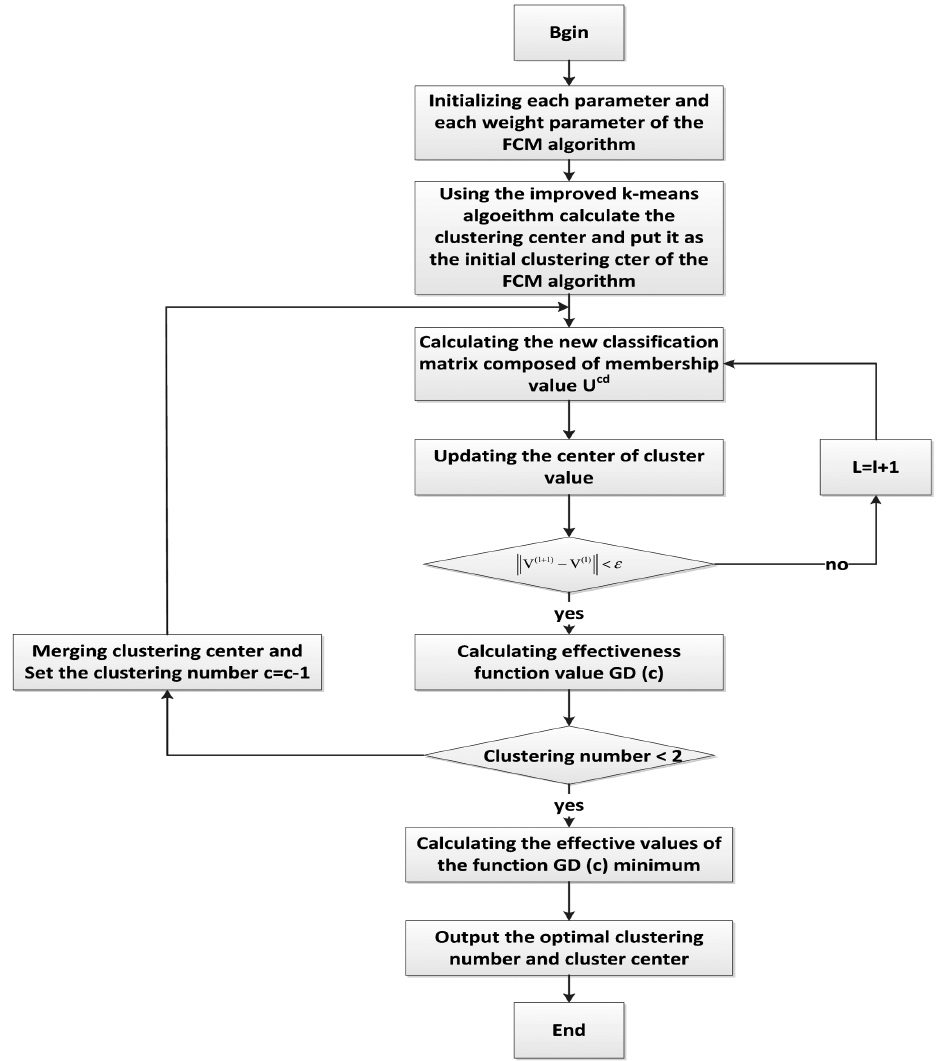
Figure 2. Flowchart of the Improved Algorithm Based on K-Means and Principle of